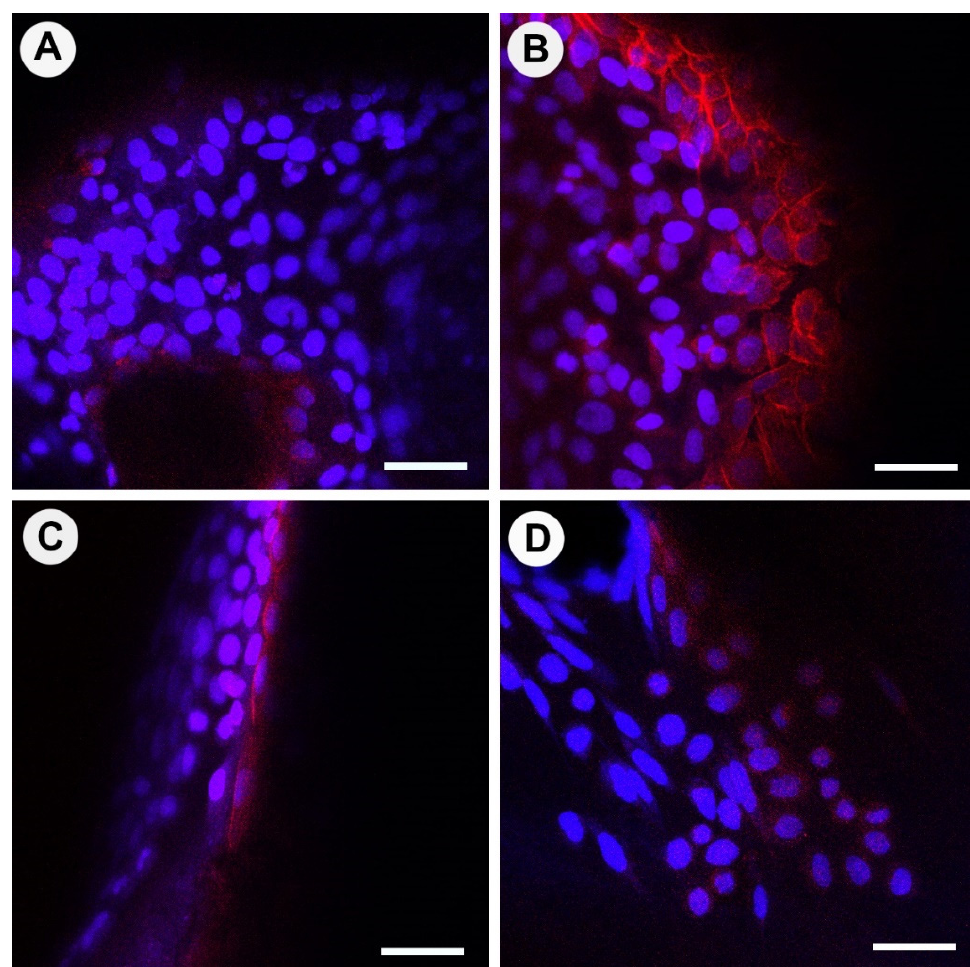
Figure 6. Confocal laser scanning microscopy (CLSM) of osteoblast actin filaments (red) and osteoblast nuclei (blue) cultured in osteogenic media for 21 days on bone scaffolds heat-treated at 100 °C ( A ), 130 °C ( B ), 160 °C ( C ), and Bio-Oss ® ( D ). Scale bar = 50 µm.